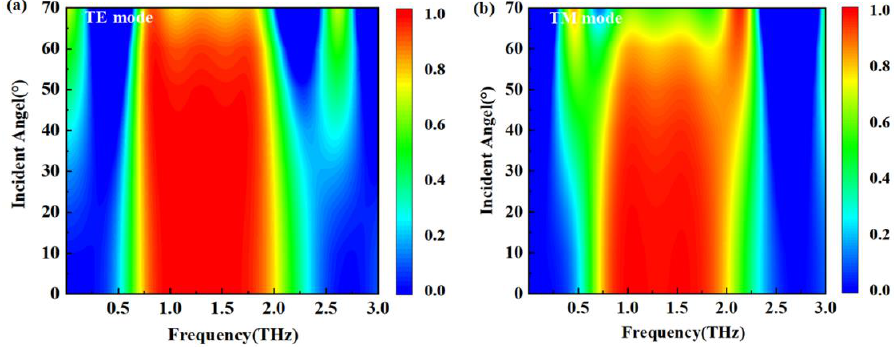
Figure 10. Absorption properties with different incident angles. ( a ) TE mode; ( b ) TM mode.